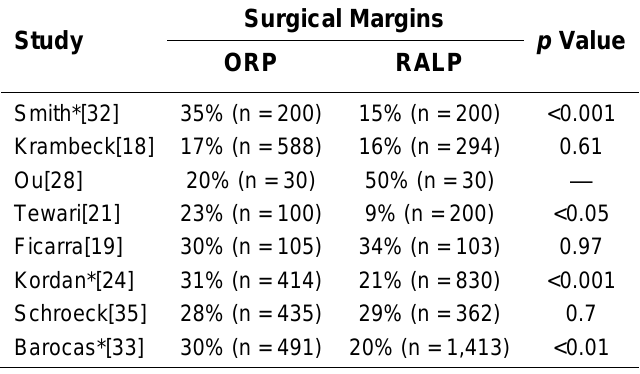
Oncologic Outcomes in Comparative Studies of ORP vs. RALP: Positive Surgical